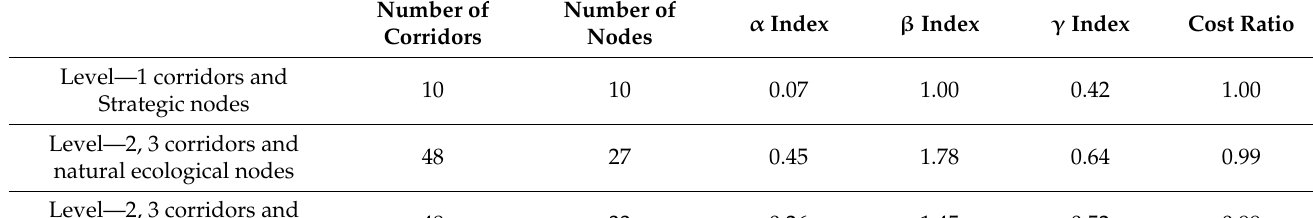
Table 8. Evaluation results of ecological network structure index.